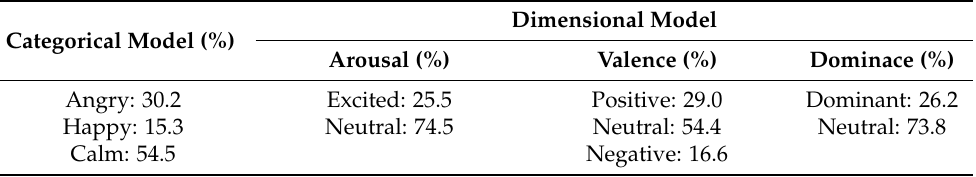
Table 1. Class distribution of the annotated data for categorical and VAD model. Dimensional Model Categorical Model (%) Arousal (%) Valence (%) Angry: 30.2 Happy: